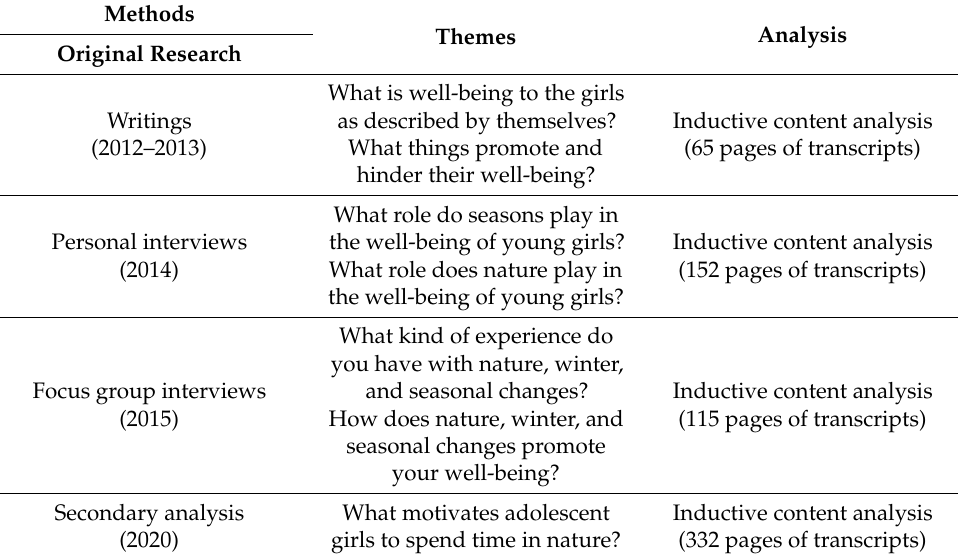
Table 1. The research questions in the original research and secondary analysis of qualitative